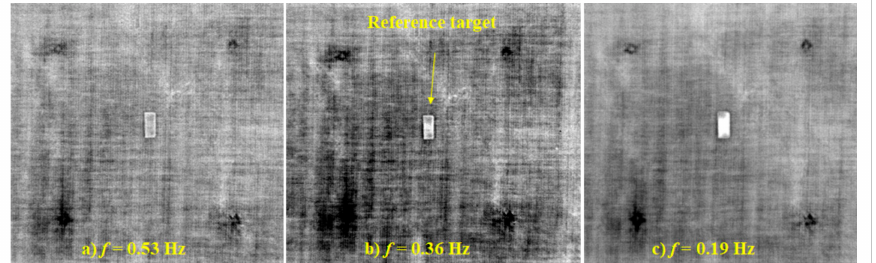
Figure 5. Phase images taken on the impacted side of the PA6B specimen at three heating frequencies; ( a ) f = 0.53 Hz; ( b ) f = 0.36 Hz; ( c ) f = 0.19 Hz (see Figure 2 for impact energies